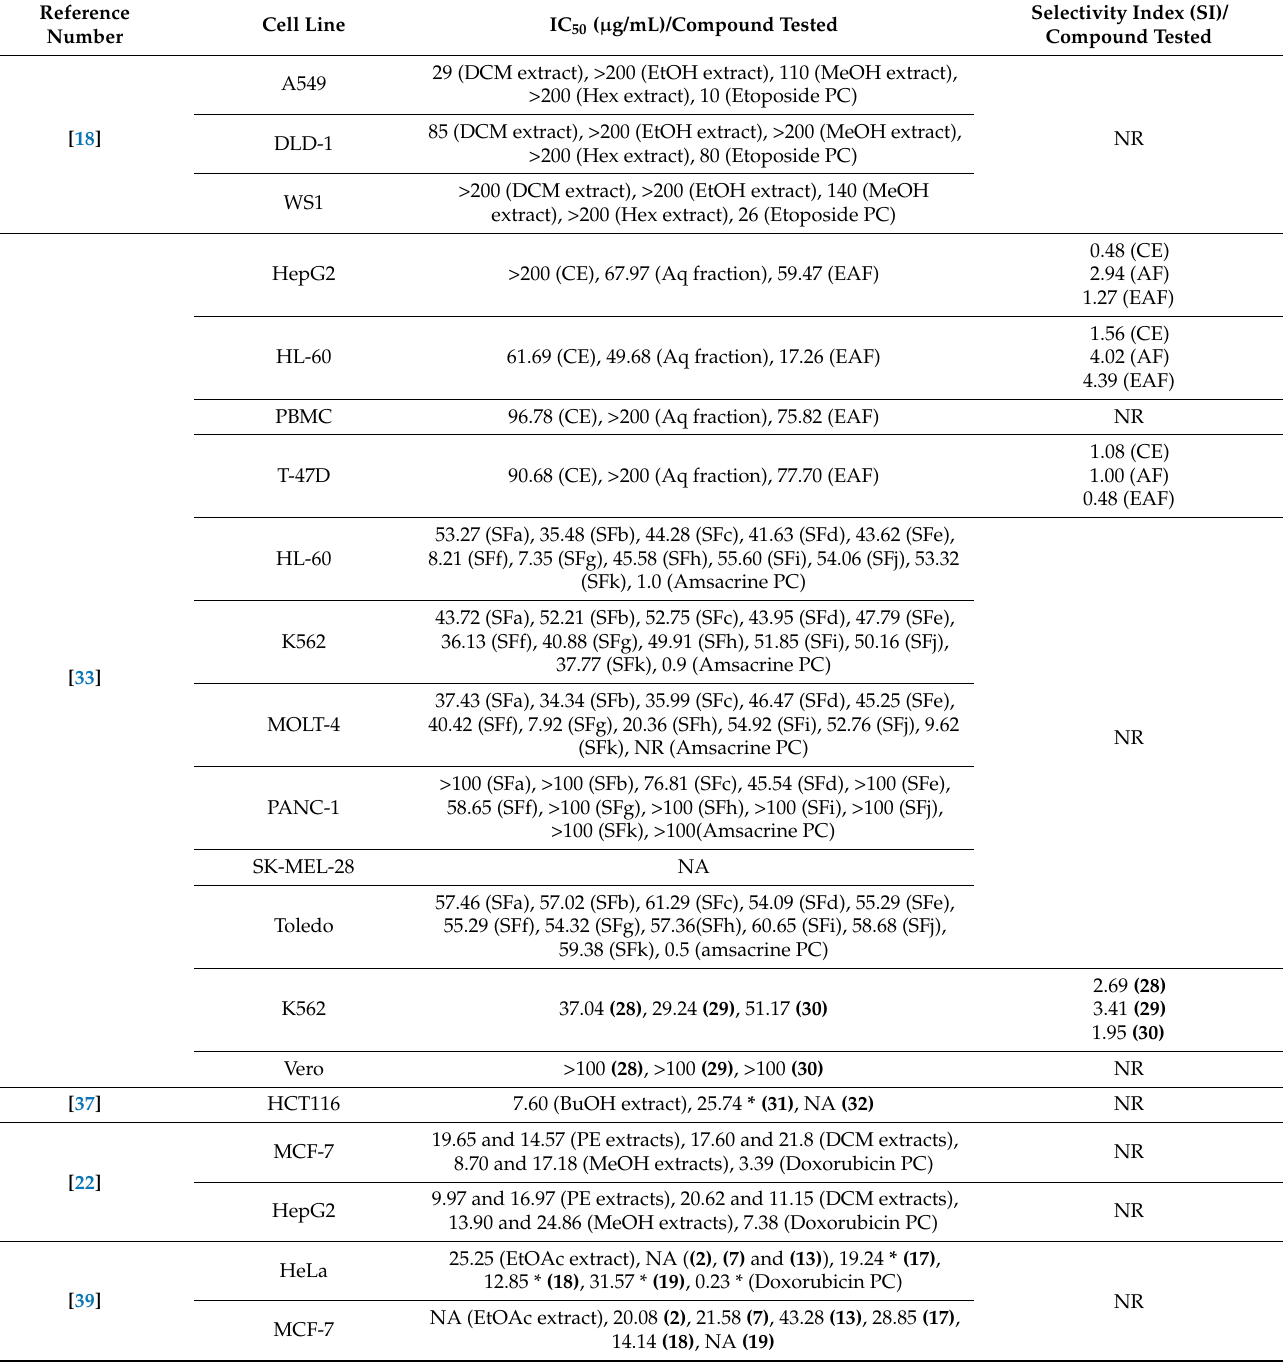
Table 3. Results of inhibitory concentration of 50% (IC 50 ) of cell proliferation based on eligible studies included in the systematic